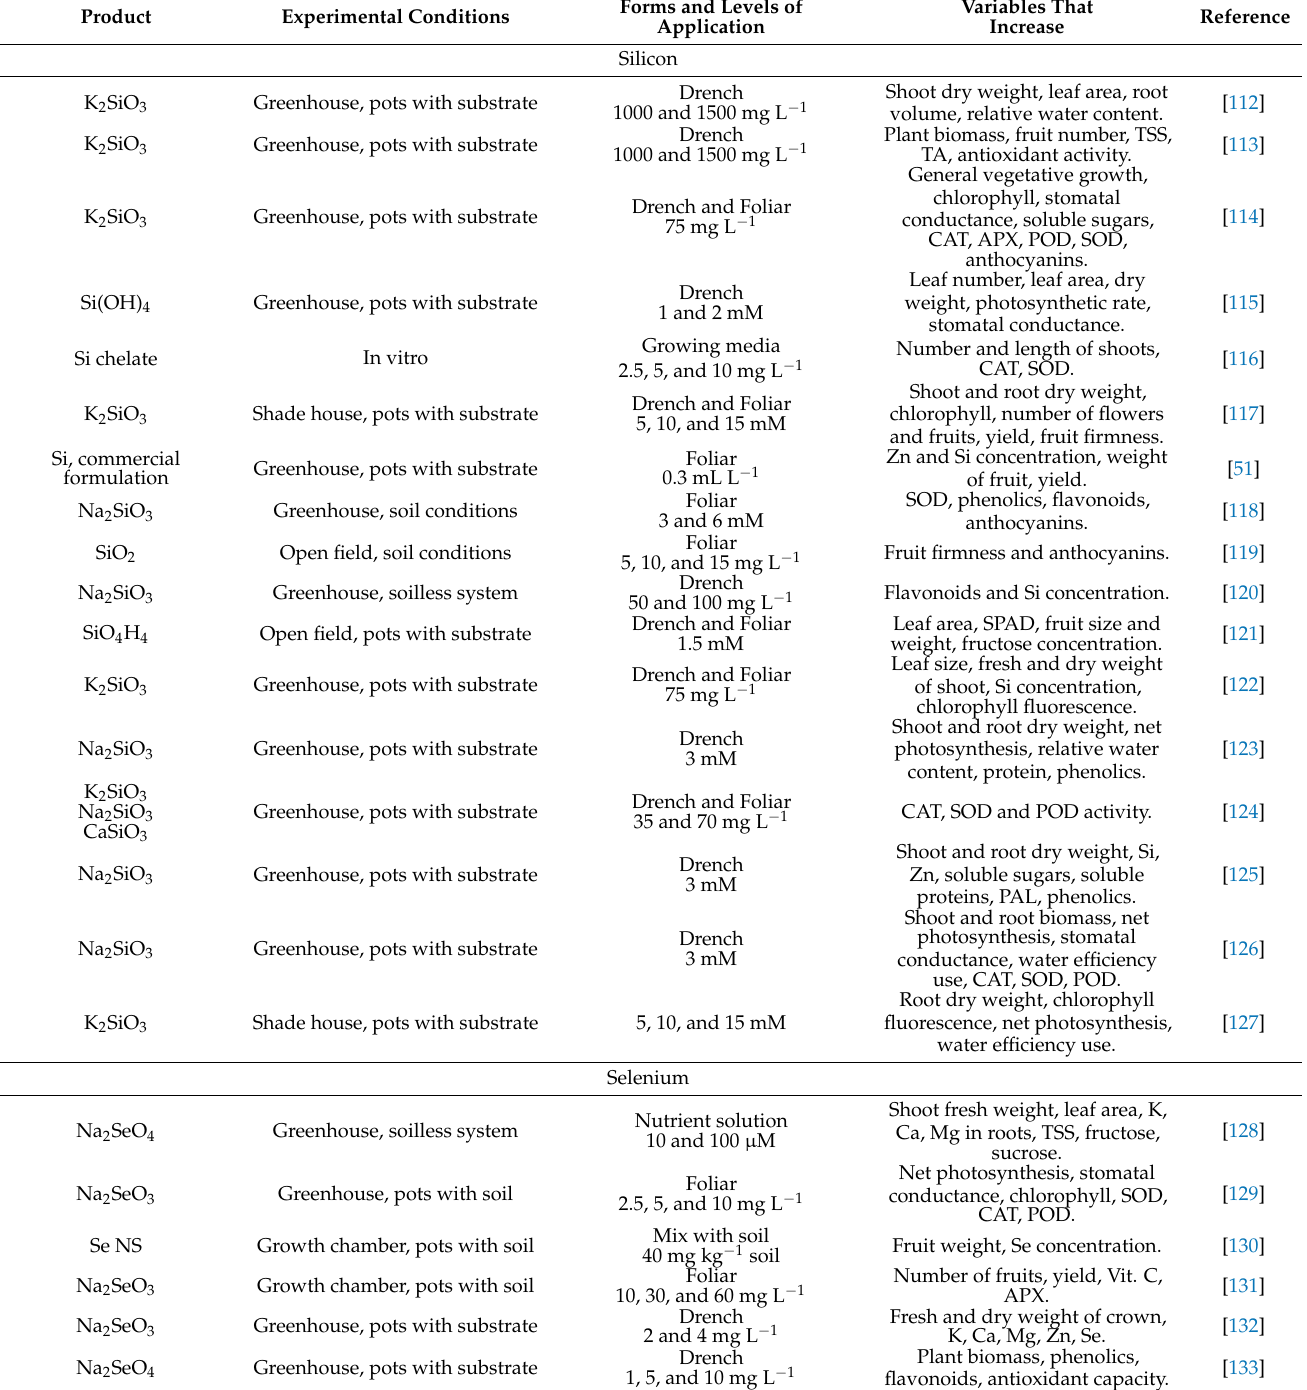
Table 5. Positive effects of beneficial element applications on some growth or quality variables of strawberry